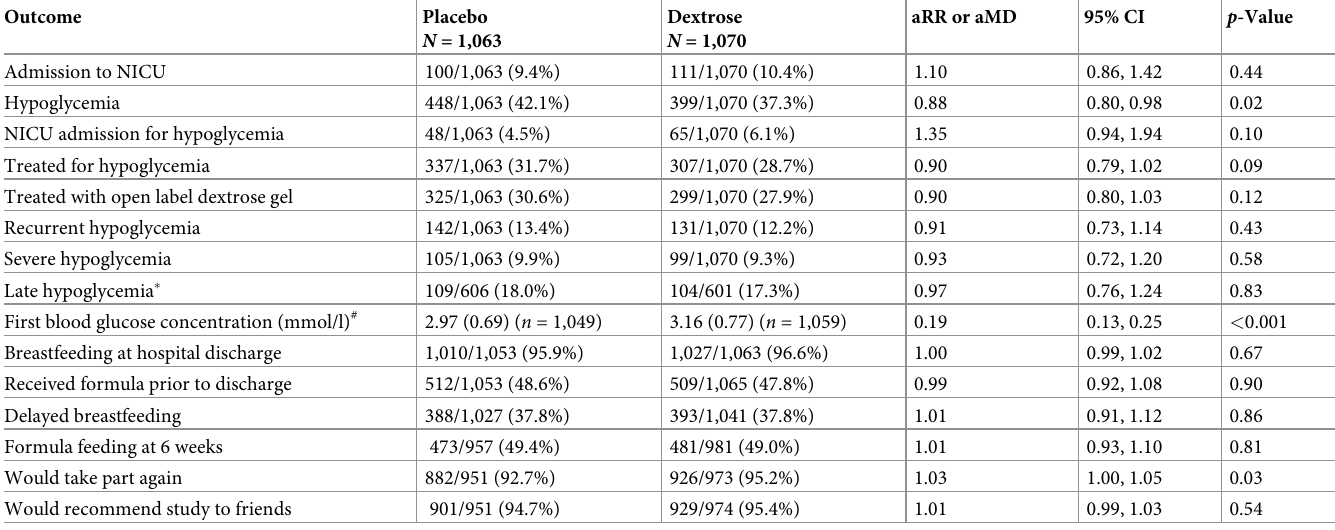
Table 2. Primary and key secondary outcomes and potential adverse